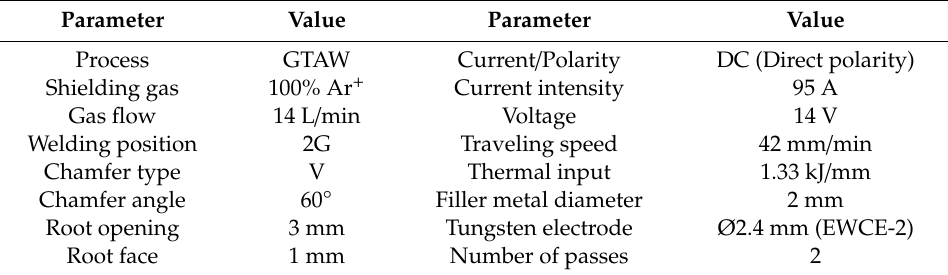
Table 4. Main parameters used in the welding